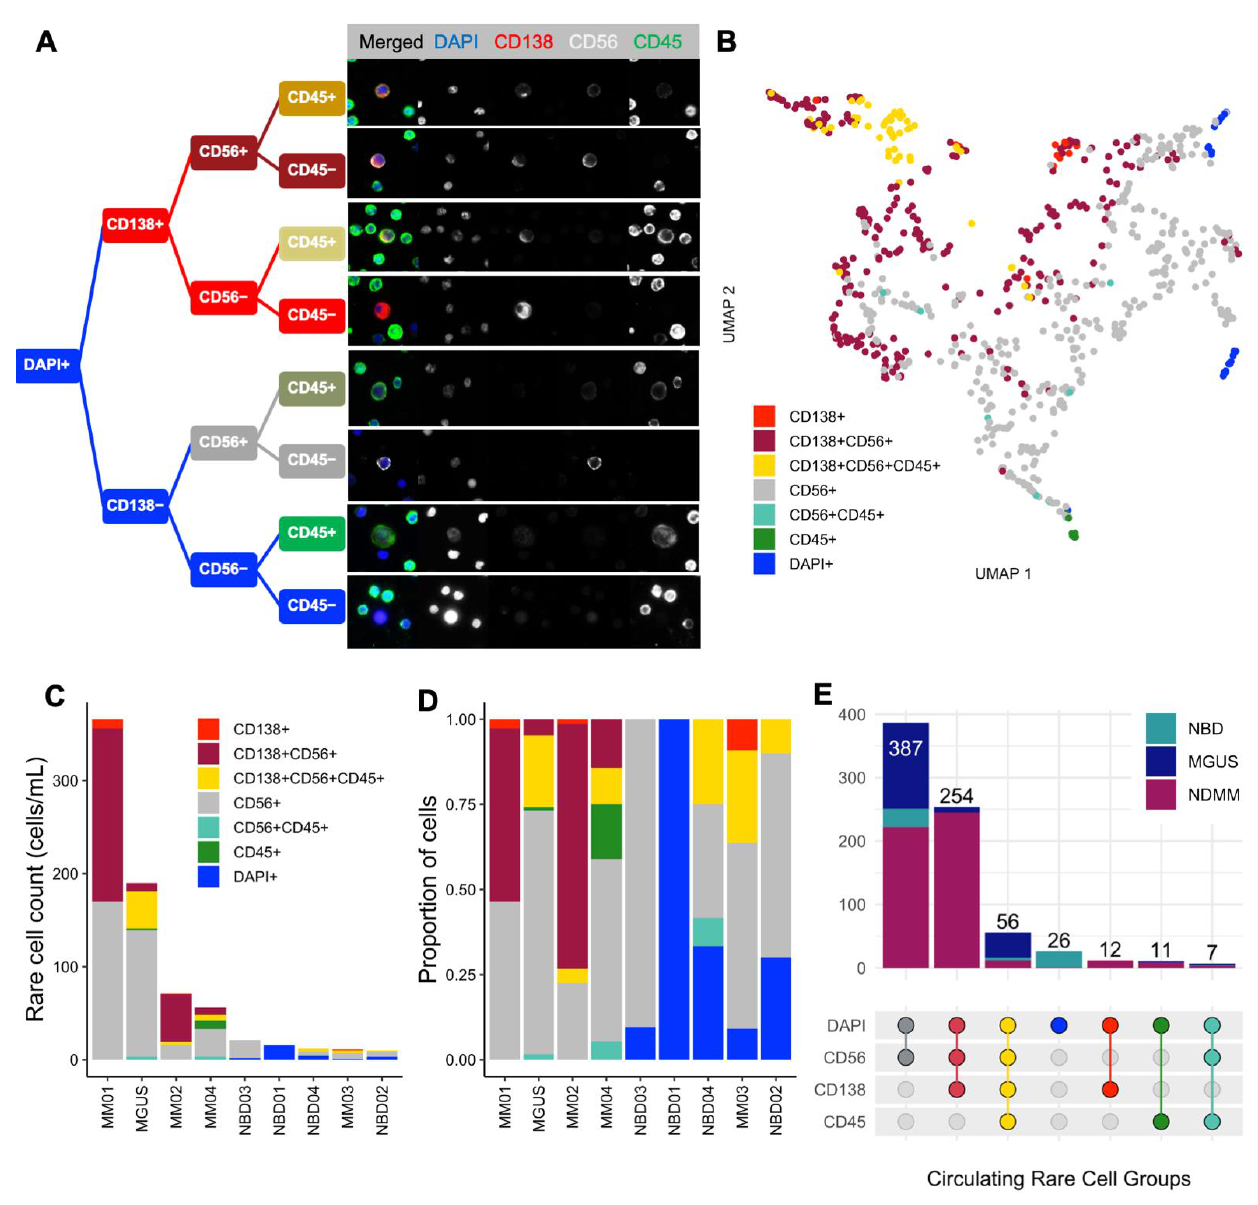
Figure 2. Rare Single-Cell Classification and Enumeration. ( A ). Decision tree structure classification of DAPI+ cells showing all candidate cell groups detected, with respect to immunofluorescence expression, along with representative images (400 × magnification). ( B ) UMAP projection of all detected circulating rare cells colored by their respective classification groups. Using the 761 features extracted with EBImage, Uniform Manifold Approximation Manifold (UMAP) [47,48], a non-linear dimensionality reduction method, was used to represent circulating rare cells and their corresponding classification groups in two-dimensional space for analysis. ( C ) Enumeration and ( D ) proportional distribution of circulating rare cells (cells/mL) for each cell group across all samples. ( E ) Distribution of circulating rare cell counts across NDMM ( N = 4), MGUS ( N = 1), and NBD ( N = 4) grouped by rare event group based on marker expression. Color scheme for cell classification groups is consistently